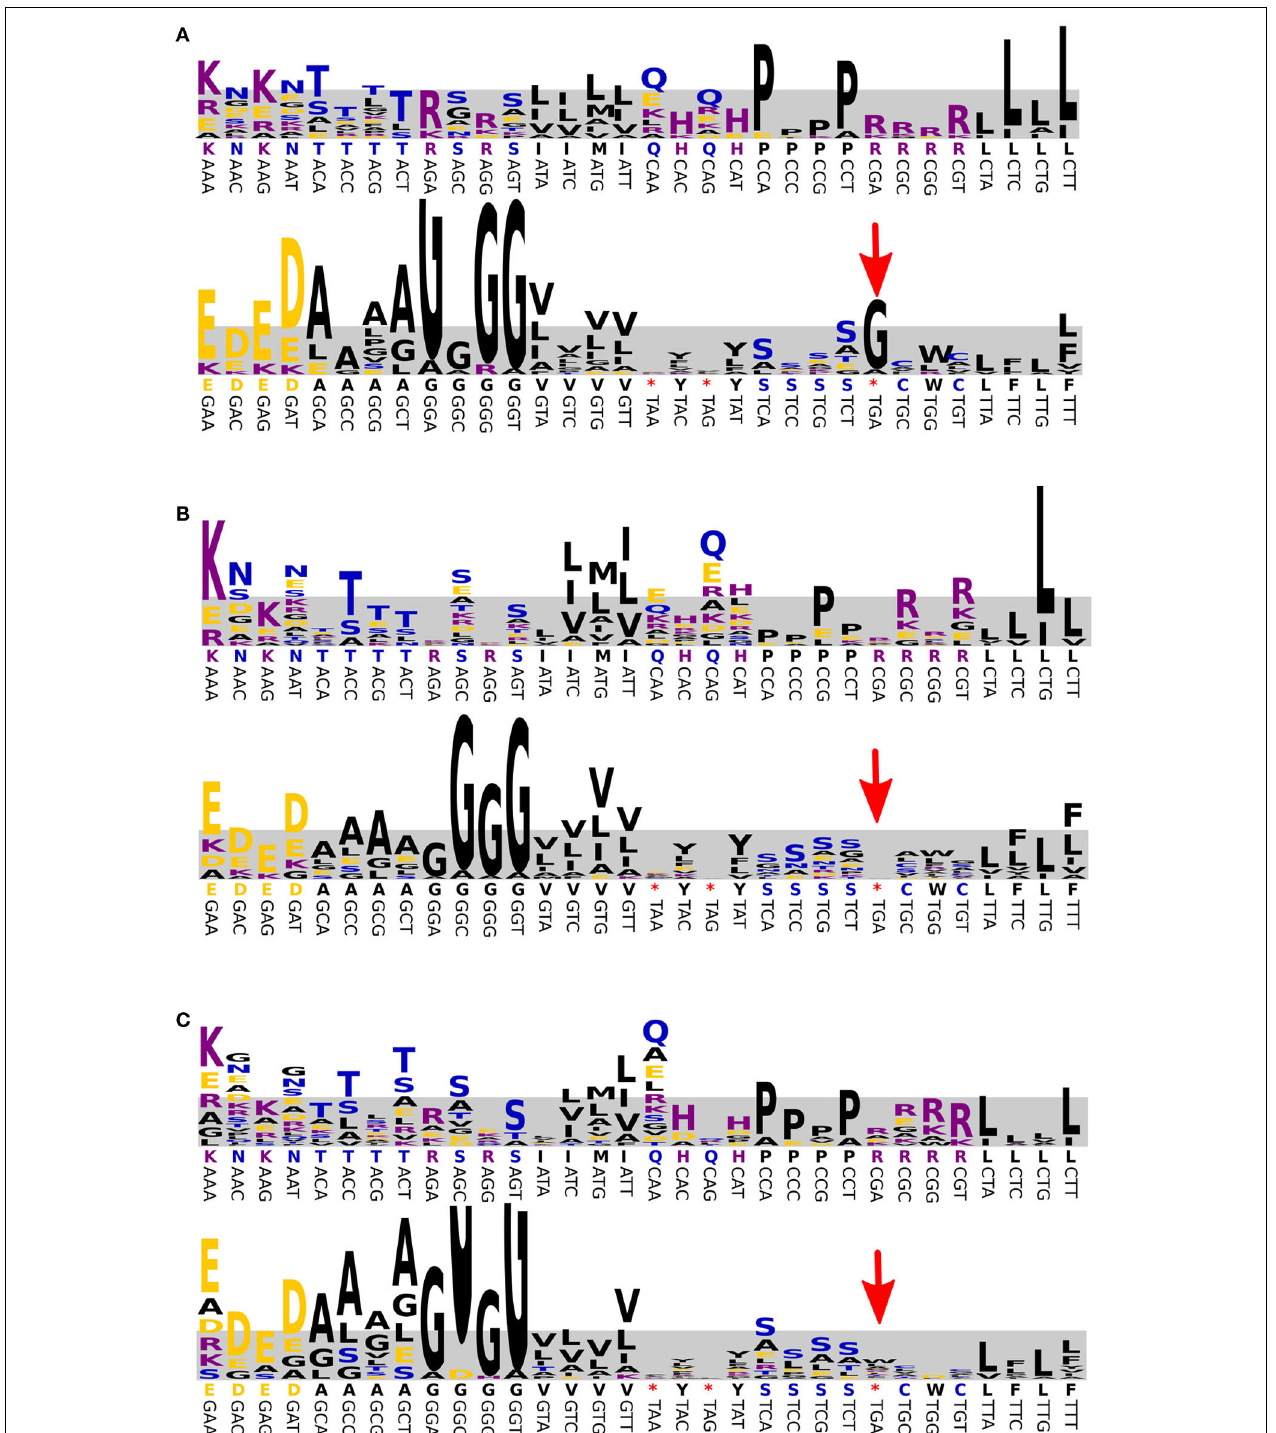
FIGURE 5 | Prediction of the genetic code used by the BD1-5/SN-2 population. The results are shown for Bin E (A) , E. coli (B) , and Mycoplasma (C) . Directly above each codon, the canonical translation is shown ( ∗ indicates a stop codon). The frequency of amino acids observed in conserved positions of conserved proteins is visualized as a WebLogo, where the height of each letter is a measure for the